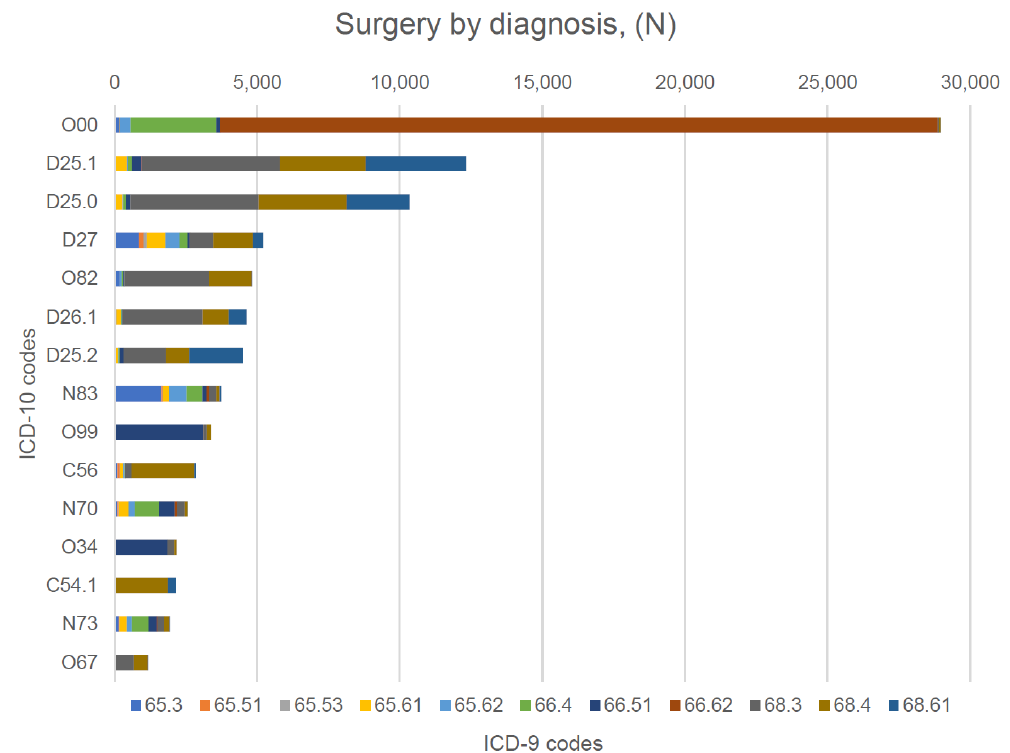
Figure 3. Types of the surgical procedures linked to the ICD-10 codes (top 15). Figure legend. ICD- 9 codes: 65.3 — unilateral oophorectomy; 65.51 — other removal of both ovaries at the same operative